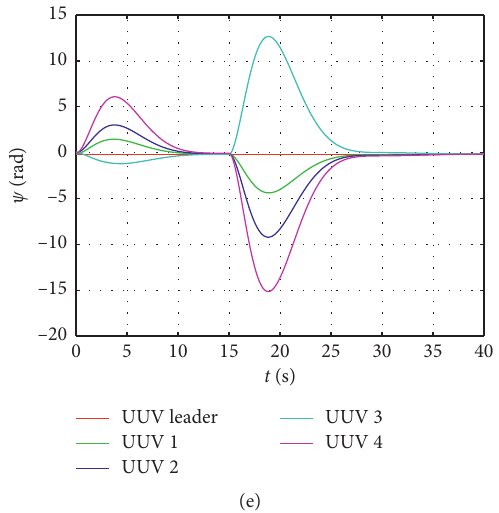
Figure 4: Position and attitude states of leader-following multi-UUVs with algorithm